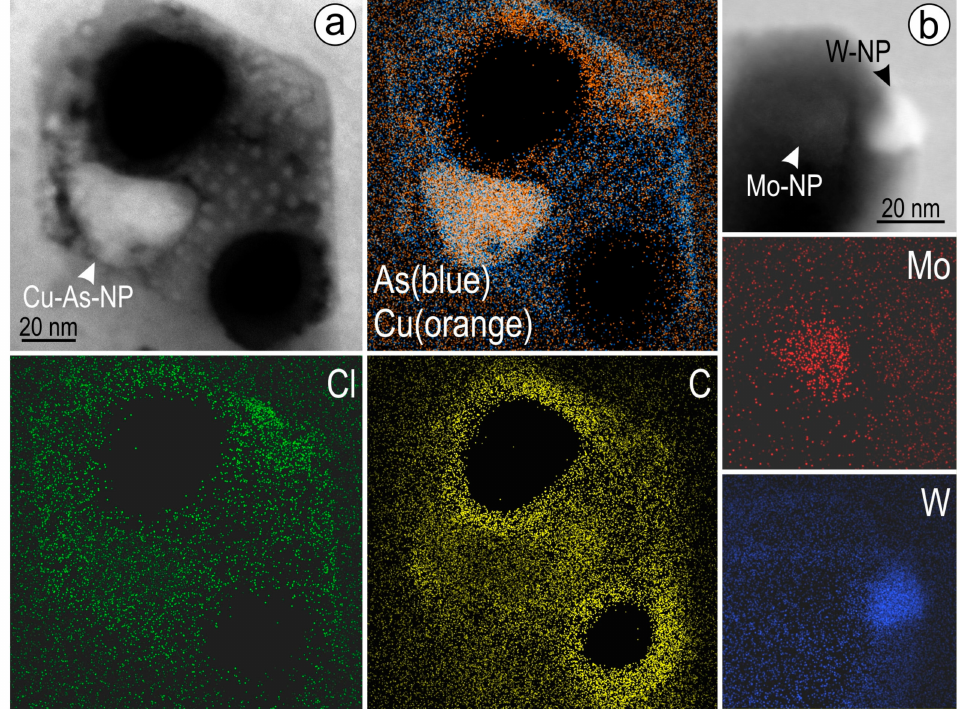
Figure 7. HAADF STEM image (upper left, right) and STEM EDX element maps (foil #3, domain B; extended maps are shown in Supplementary Material Figures S3 and S4) of ( a ) coarse negative crystal shaped cavity showing the presence of Cu, As, Cl and C, and ( b ) the presence of W and Mo NPs within the cavity. Copper and As are highest and overlap, indicating a Cu-As NP. The other elements are likely retained on the wall of the cavity. Note the rounded voids are